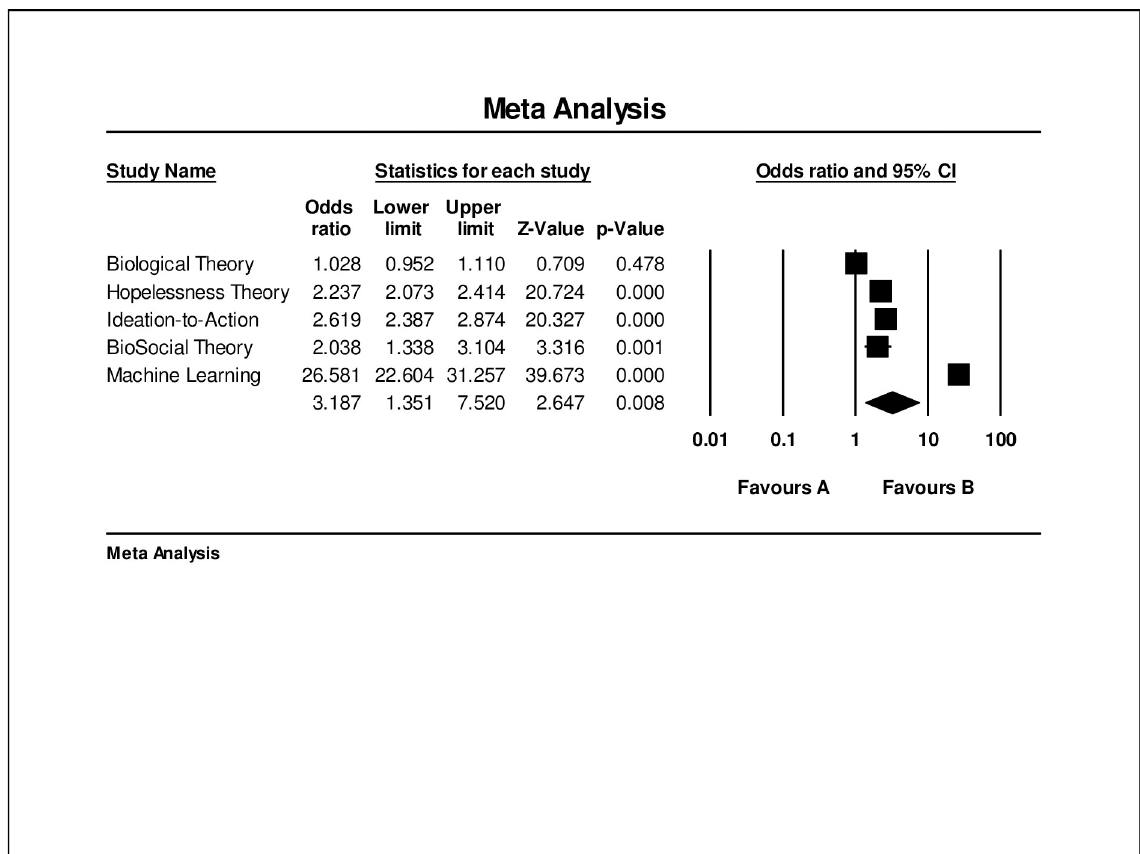
Fig 3. Odds ratios of each paradigm in prediction of combined STB